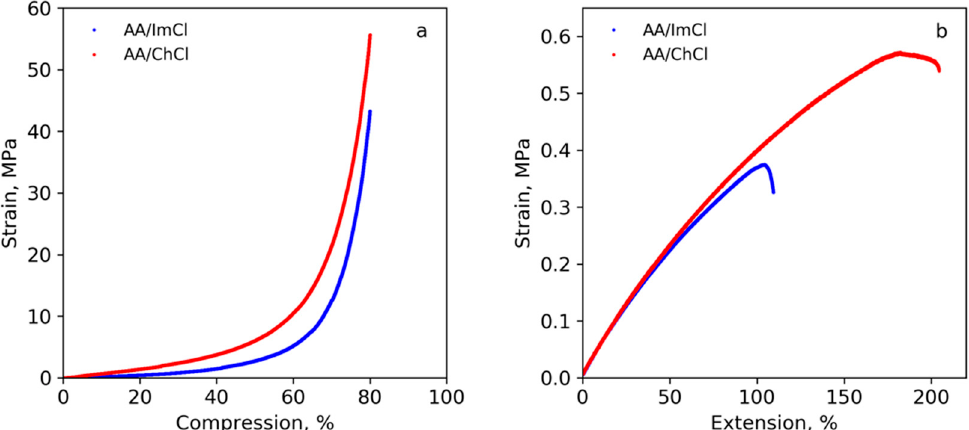
Figure 10. Stress–strain curves of AA/ChCl- and AA/ImCl-based samples prepared by polymerization in bulk and measured in compression mode ( a ) and prepared via 3D-printing and measured in extension mode ( b ).